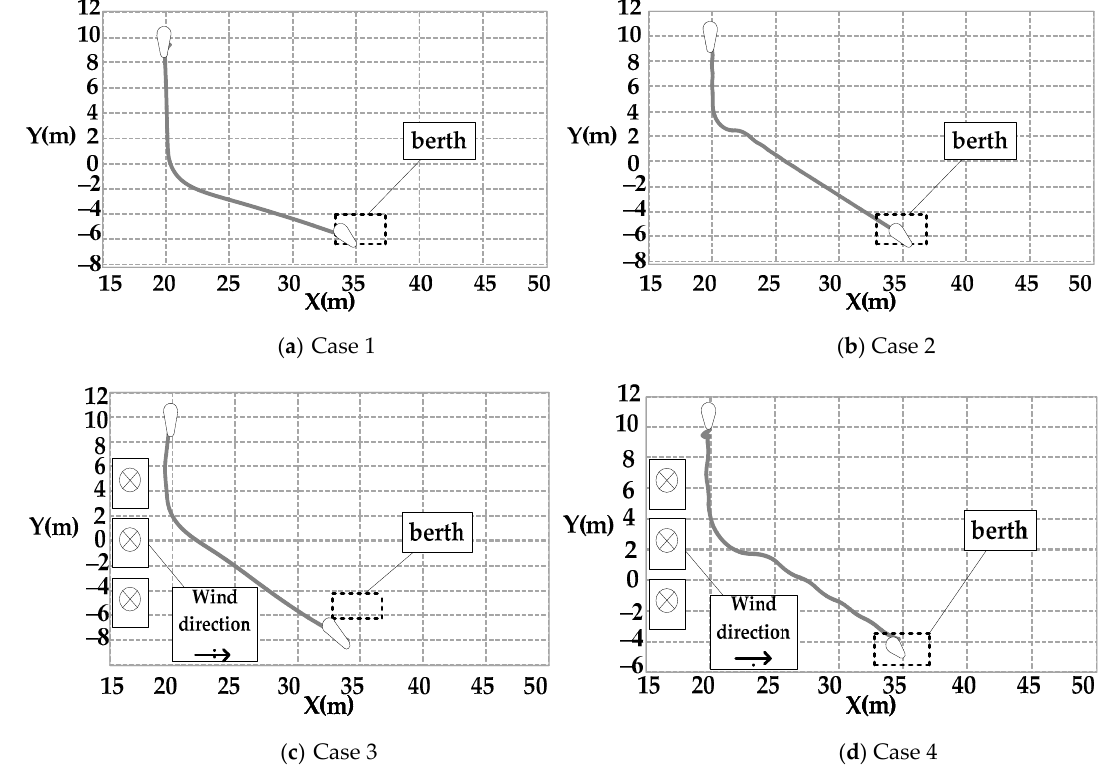
Figure 16 . Ship trajectory in the tank experiment of ship automatic berthing.